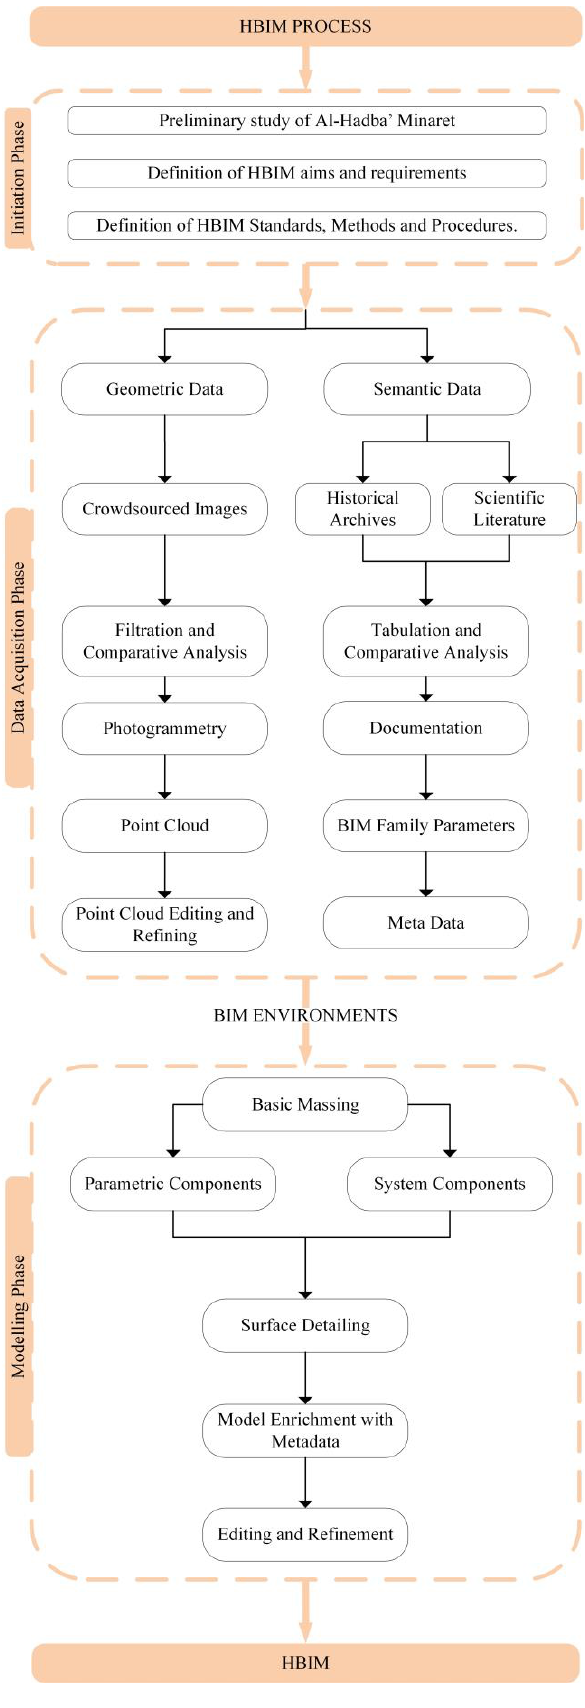
Figure 3. Al-Hadba’s HBIM reconstruction